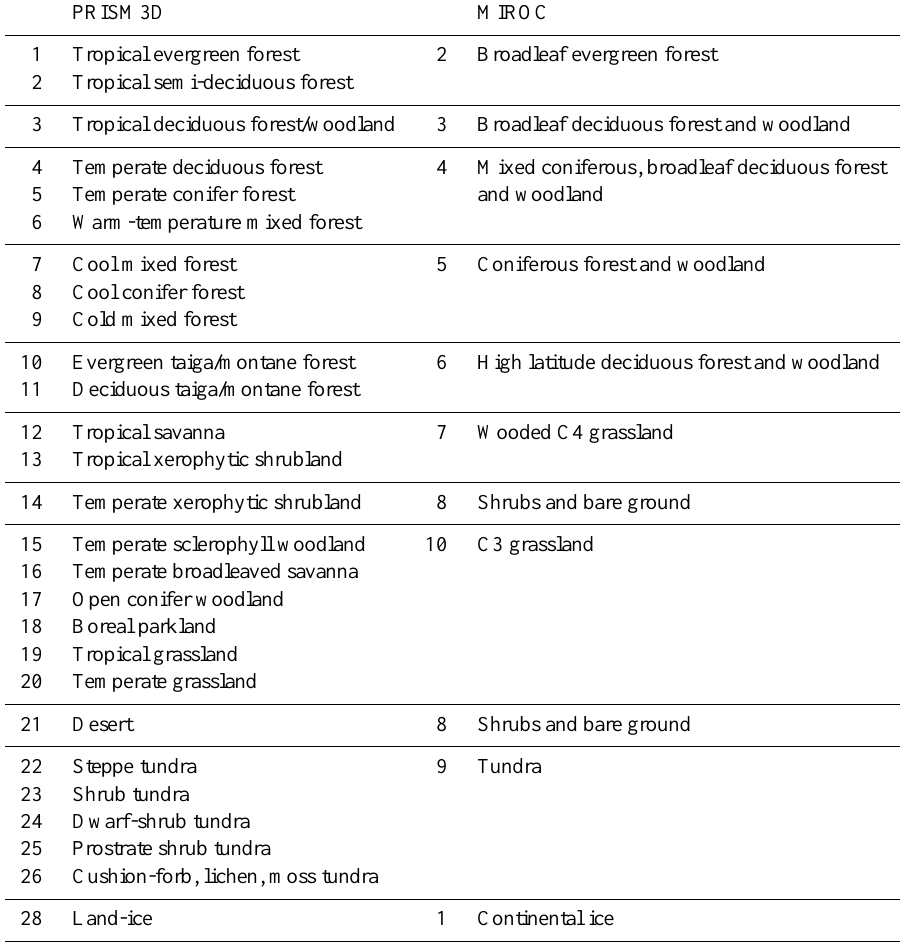
Table 2. Vegetation type in the PRISM3D data set and in MIROC, and the scheme used to convert the former to the latter for the mid-Pliocene